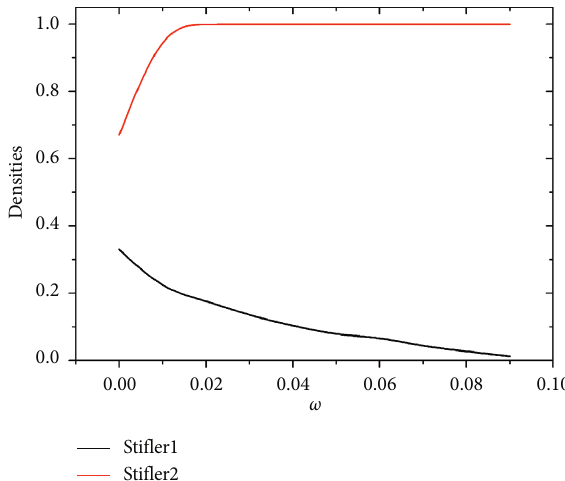
Figure 9: Density of spreader1 over time for different values of 〈 k 〉 . Figure 10: Density of stifler1 and stifler2 for different values of ω at steady state.